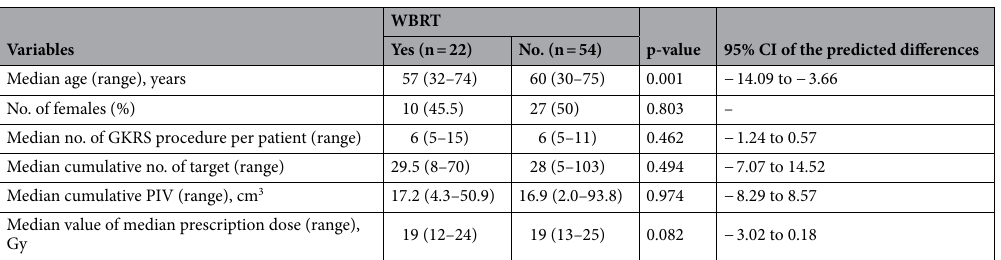
Table 4. Comparison of the baseline characteristics of the two groups of patients according to the WBRT status. GKRS gamma knife radiosurgery, PIV prescription isodose volume, WBRT whole brain radiotherapy, CI confidence